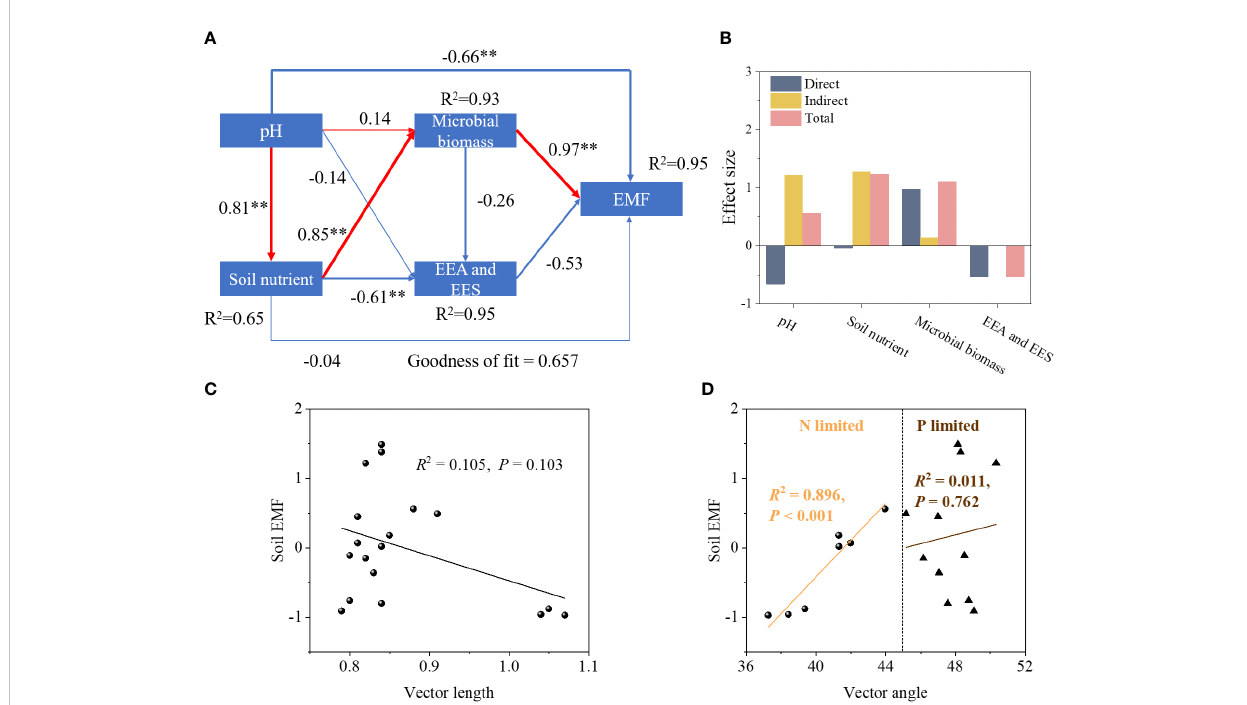
FIGURE 4 The correlation between soil factors, vector characteristics and soil EMF. (A) PLS-PM model; (B) effect size; (C) vector length; (D) vector angle. EMF, ecosystem multifunctionality. The red and blue lines indicate positive and negative effects, respectively. ** P <